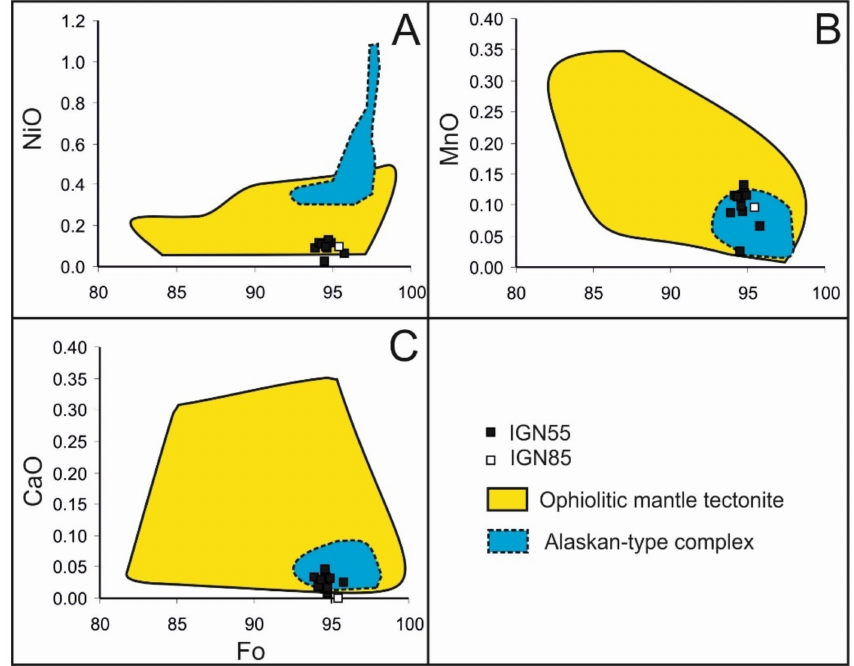
Figure 8. Variation of NiO ( A ), MnO ( B ) and CaO ( C ) as functions of forsterite (Fo) molar % in olivine included in chromite from high-Cr chromitite of Sebuku Island and comparison with olivine associated with chromitite hosted in ophiolitic mantle tectonite and Alaskan-type complex (field from Garuti et al. [45]).